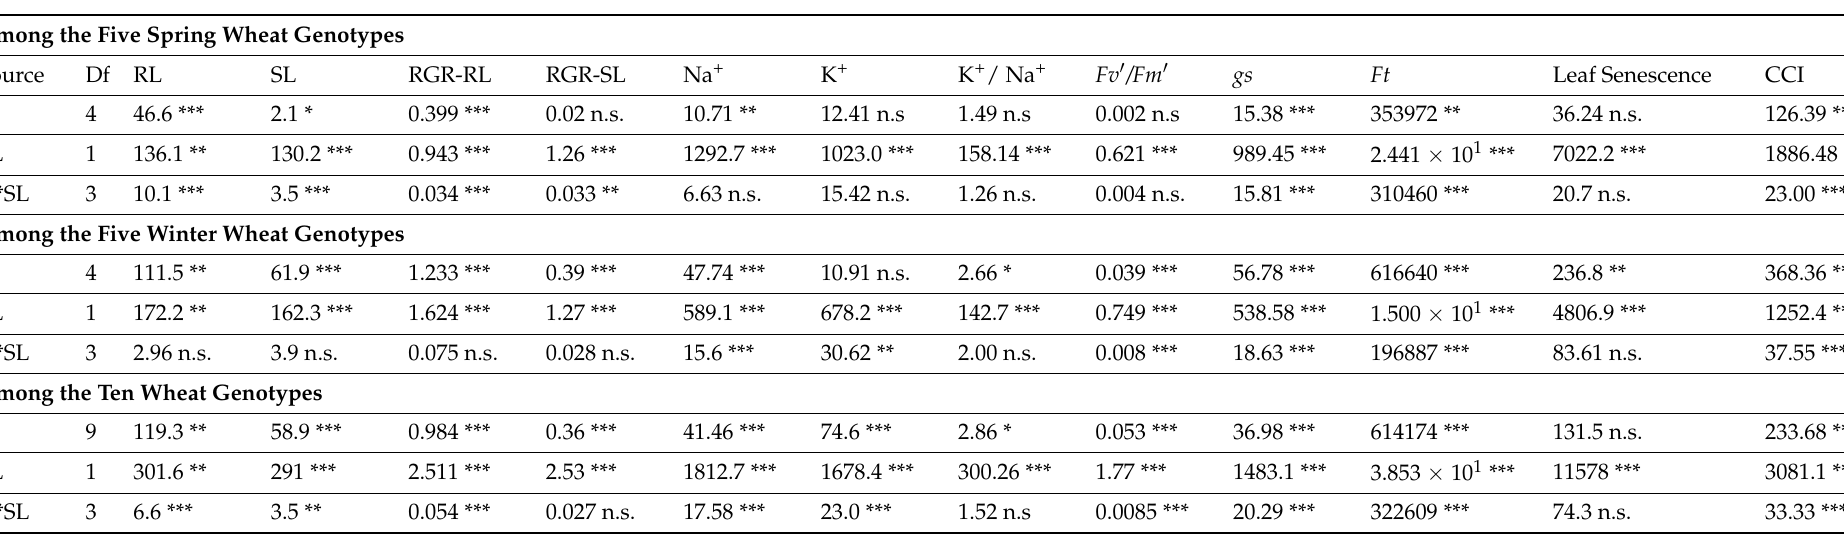
Table 1. Mean square values ( p < 0.05) for root length (RL), shoot length (RL), the relative growth rate of root length (RGR-RL), the relative growth rate of shoot length (RGR-SL), leaf Na + and K + concentration (mg g − 1 dry wt), K + /Na + ratio, stomatal conductance gs (mol/m 2 s), maximum quantum efficiency of PSII ( Fv (cid:48) /Fm (cid:48) ), instantaneous chlorophyll fluorescence ( F t